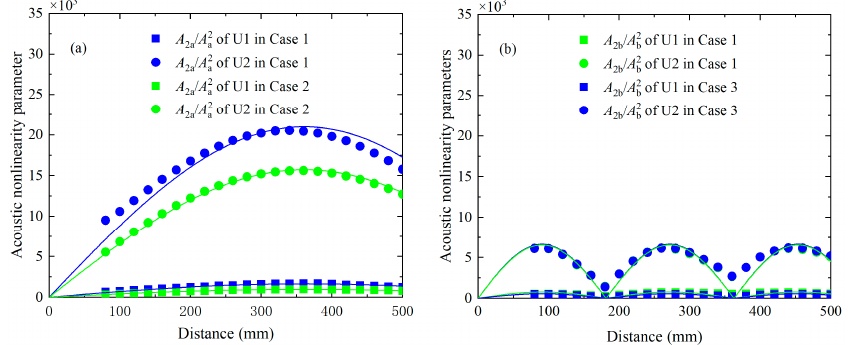
which are fitted by Equation (6).